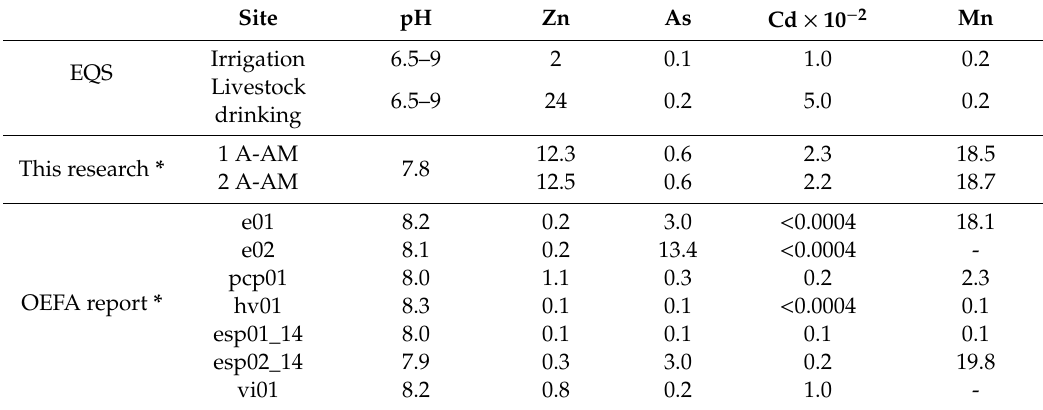
Table 5. Total metal concentrations (mg L − 1 ) in water samples exceeding Environmental Quality Standards (EQS) in the Cunas sub-basin.